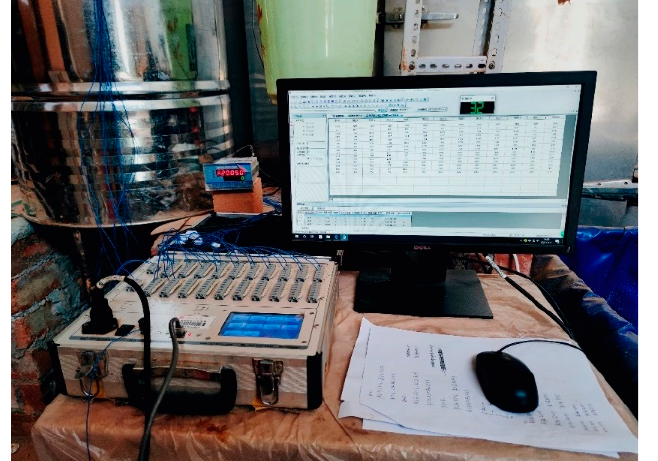
Figure 6. TST3822EN wireless static strain test and analysis system.